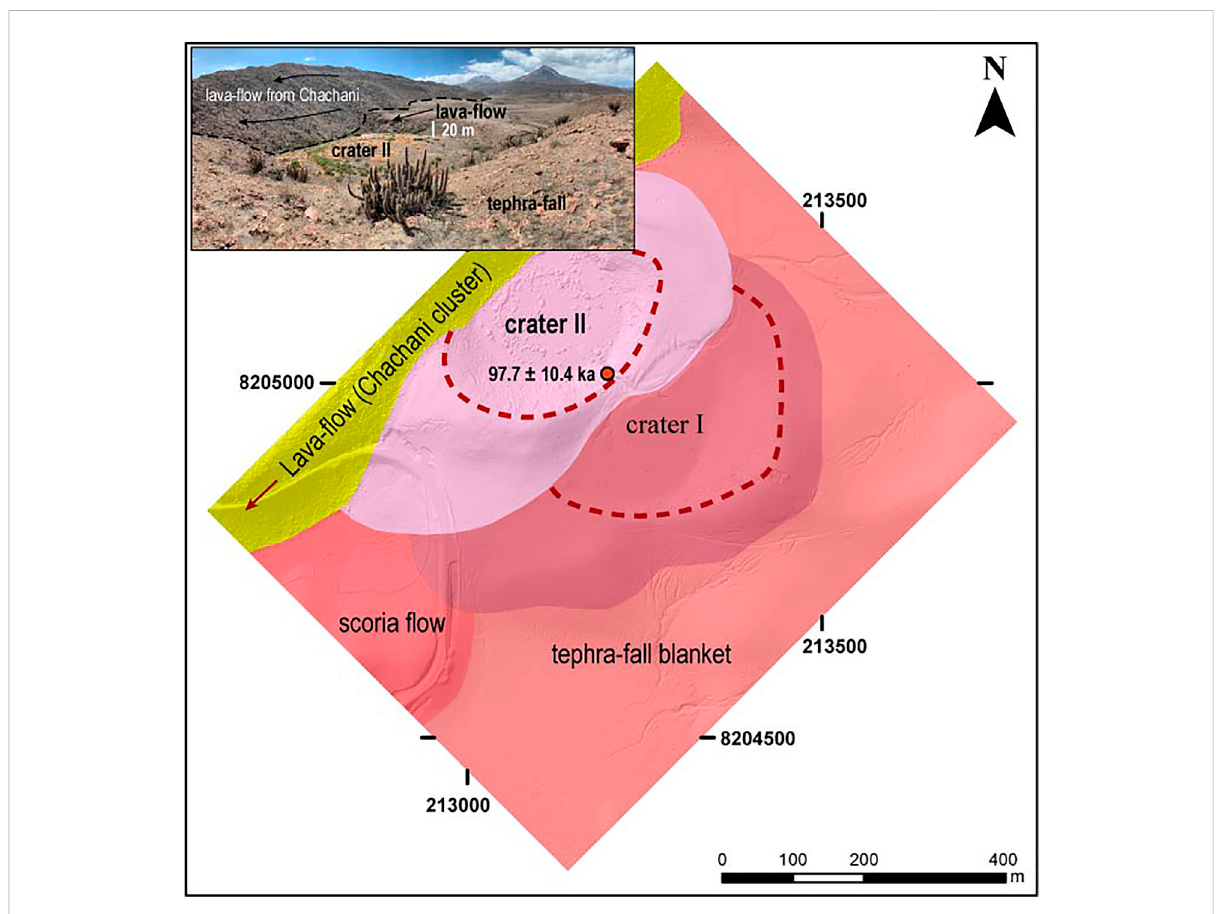
FIGURE 4 GeologicalmapofCcapuamaar,embeddedona60-cmresolutiondigitalElevationModel (DEM)map.Ontheupper-leftcorner,aphotograph of crater II partially covered by a blocky lava fl ow from Chachani volcano cluster (Aguilar et al.,